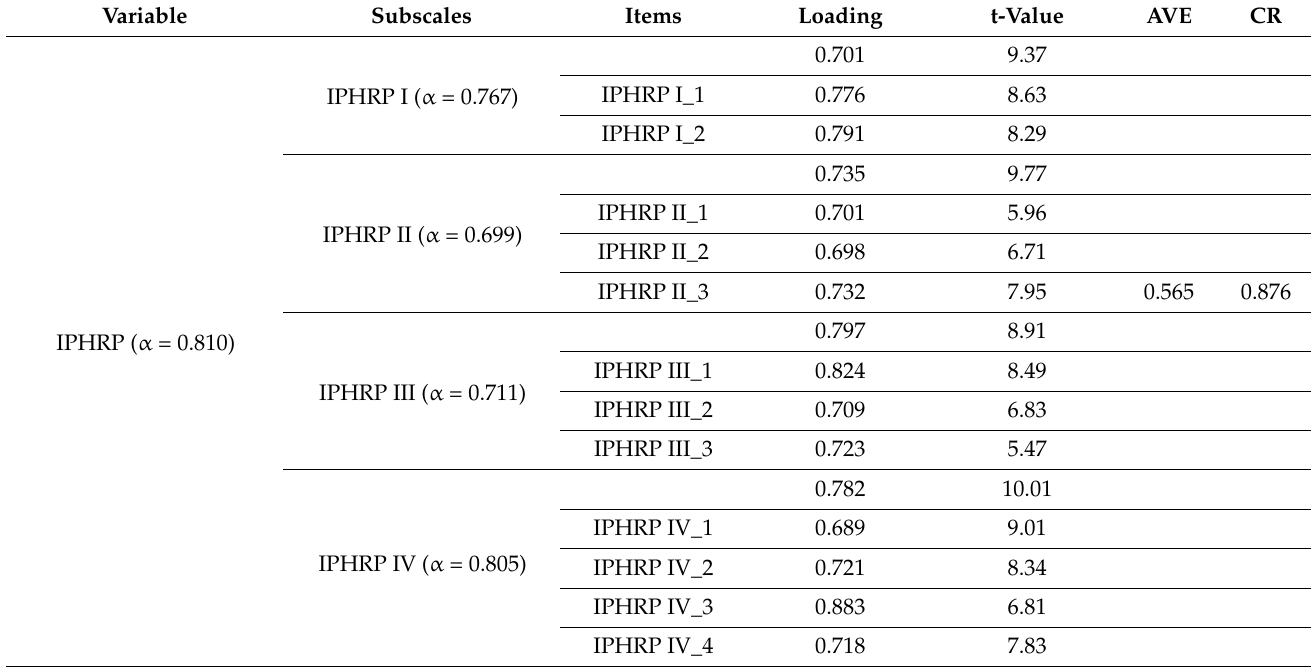
Table 2. Constructs, measures and factor